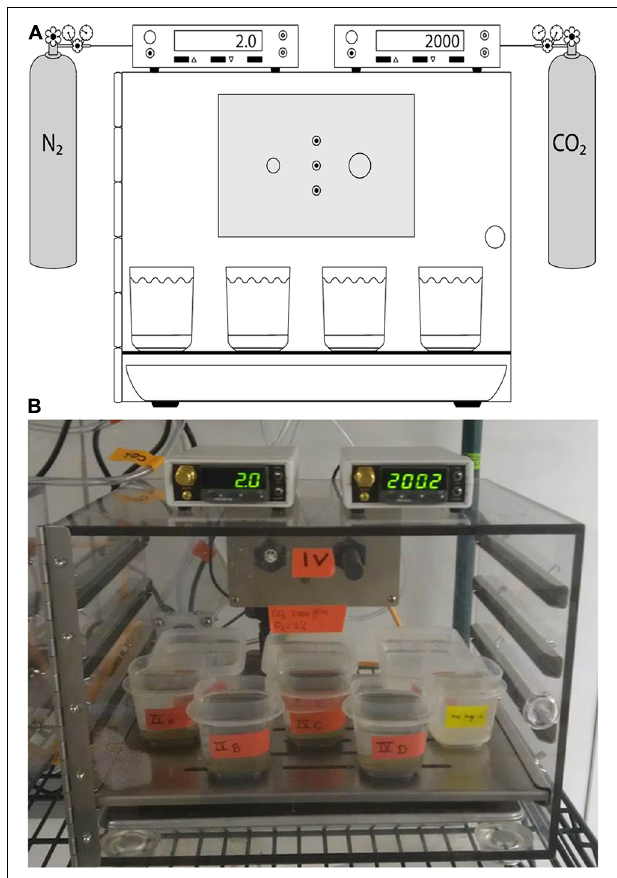
FIGURE 1 | Schematic (A) and photograph (B) showing Treatment 4 (OA + Hypoxia). The controller on the left reads % O 2 ; the right controller reads p CO 2